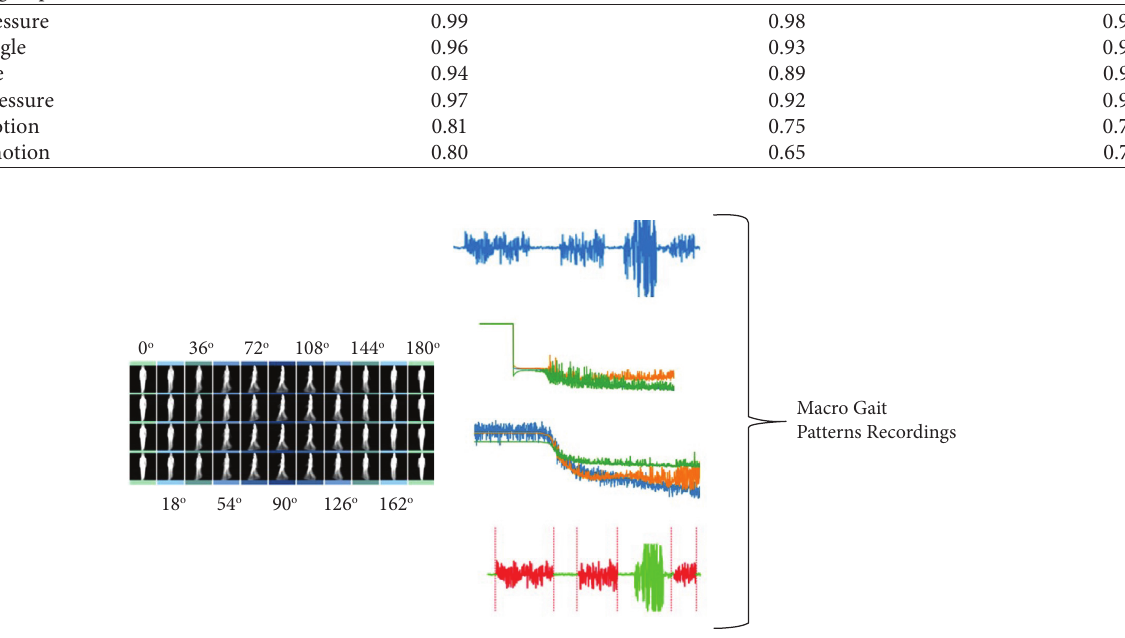
Physical activity counts and intensity